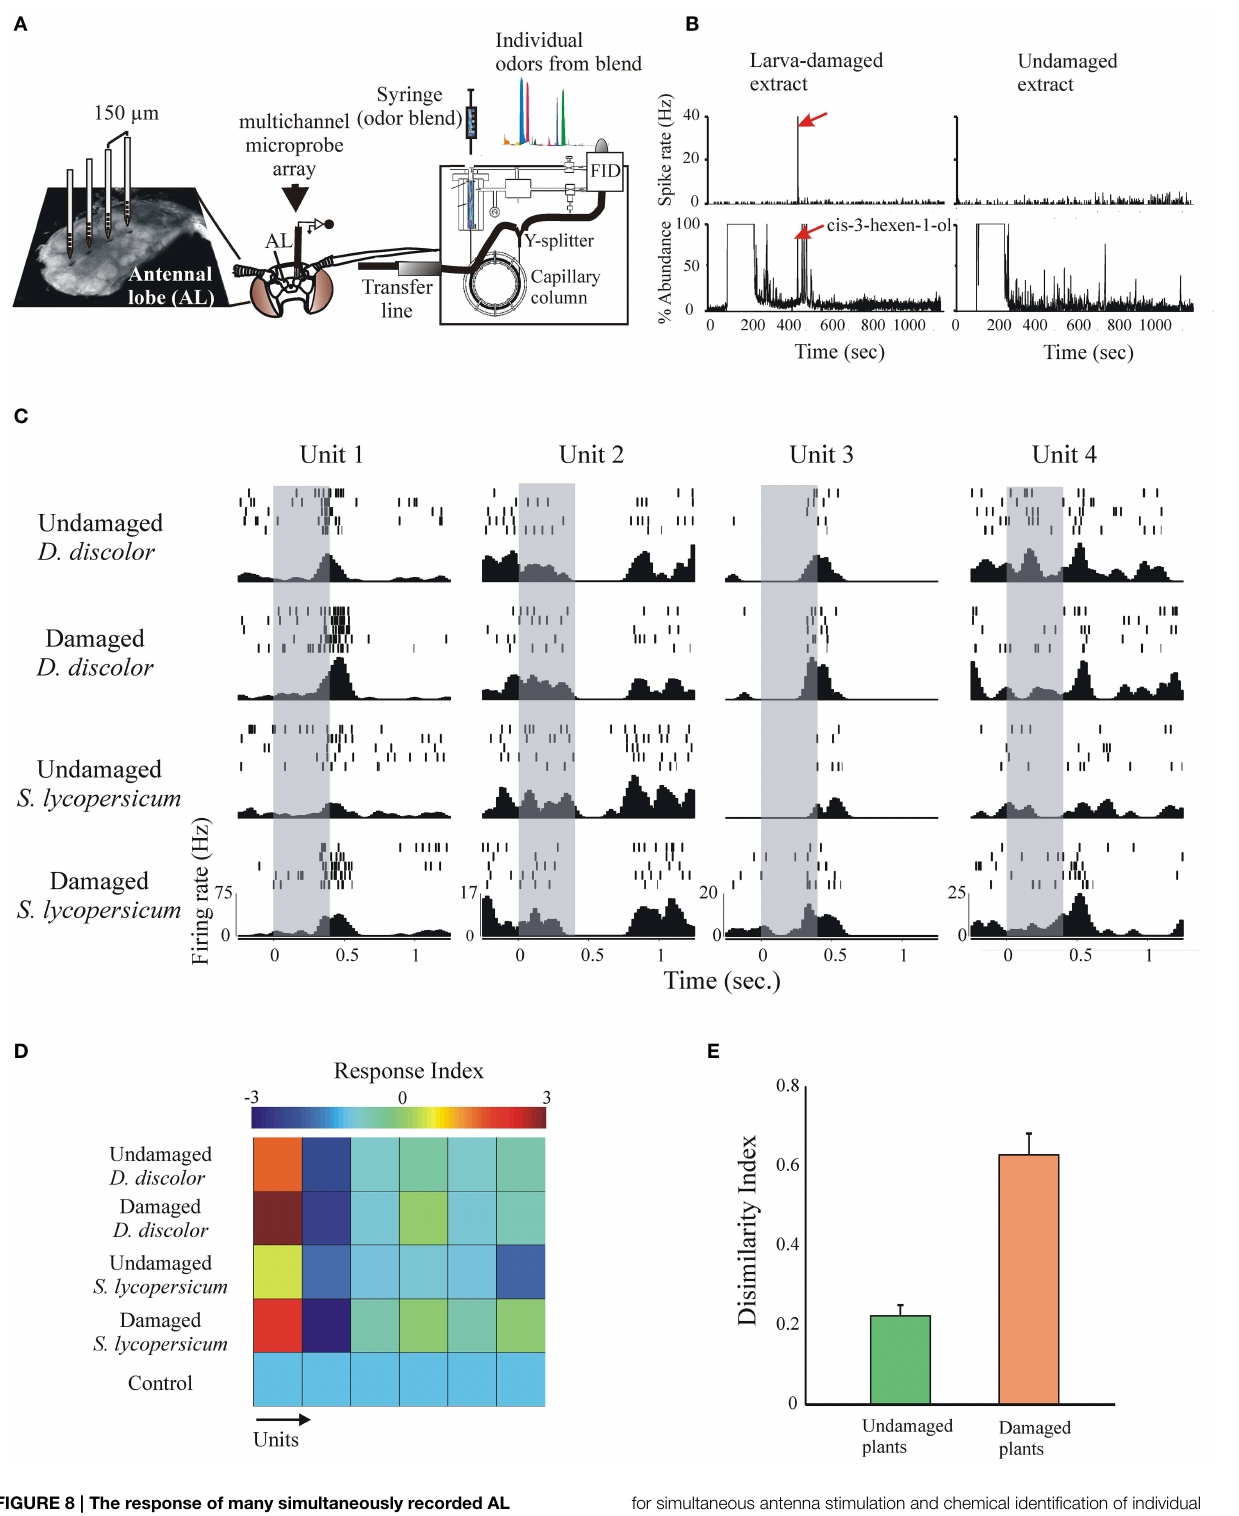
for simultaneous antenna stimulation and chemical identification of individual components. (B) GC-MRA analysis showing a neuron with robust responses to the larva-damaged VOCs responding selectively to only one peak in the GC effluent (arrow, cis-3-hexen-1-ol). (C) Simultaneously recorded